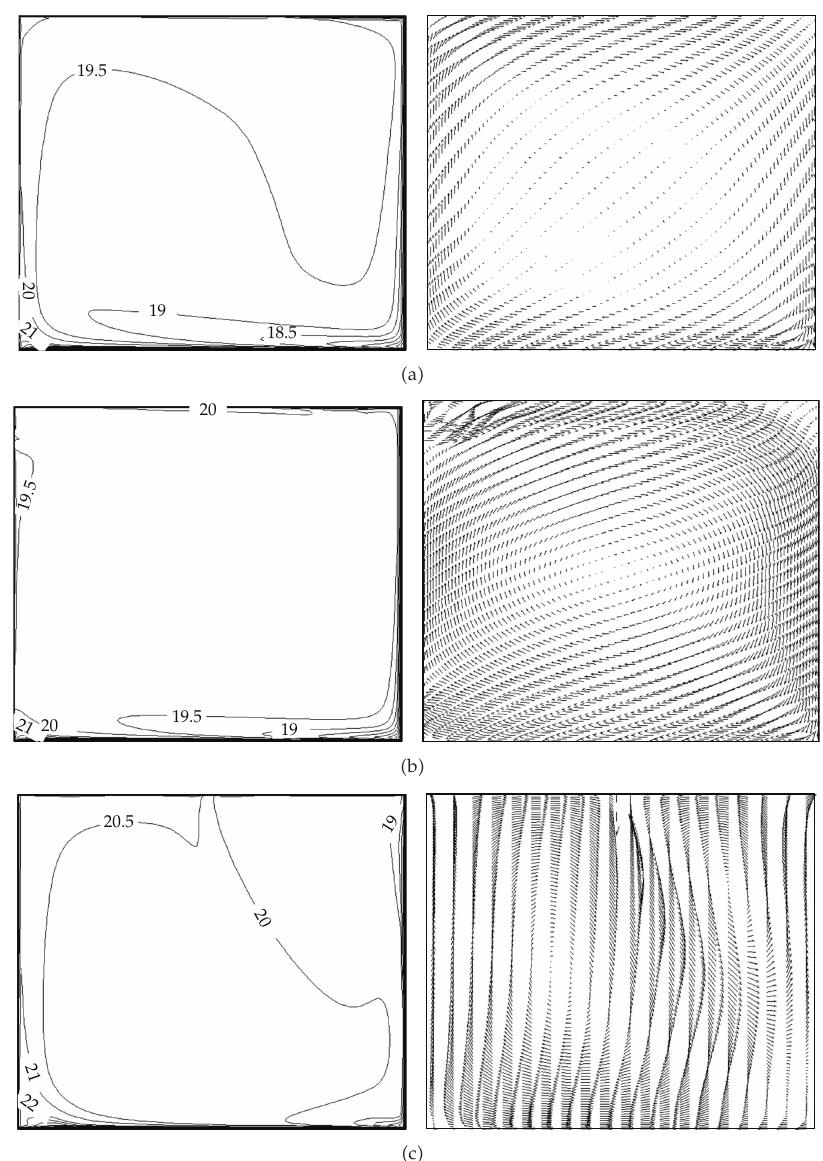
Figure 2: The temperature and velocity distribution at T fl (cid:8) 30 ◦ C, q ow (cid:8) − 100 W/m 2 and u in (cid:8) 0.3m/s for (cid:5) a (cid:6) no slot-ventilation (cid:5) NSV (cid:6) , (cid:5) b (cid:6) lateral slot-ventilation (cid:5) LSV (cid:6) , and (cid:5) c (cid:6) ceiling slot-ventilation (cid:5) CSV (cid:6)